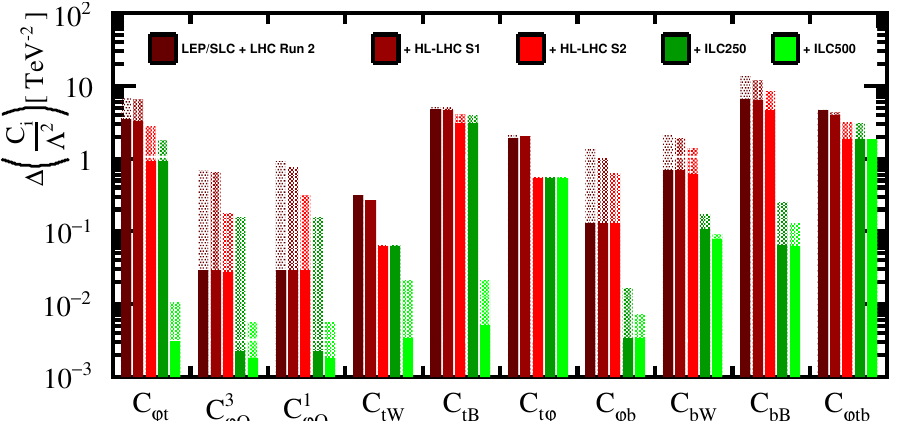
Figure 4 . Prospects for the precision of the Wilson coe(cid:14)cients in future high-luminosity operation of the LHC and at a high-energy e + e (cid:0) collider. Assumptions on the operating scenarios and details of the uncertainty estimates are given in text. The solid section of the bars represents the individual constraints, where each parameter is (cid:12)tted in isolation, the full length indicates the marginalized constraint in a ten-parameter (cid:12)t. The complete covariance matrices of the (cid:12)ts that are presented in this (cid:12)gure are available in appendix